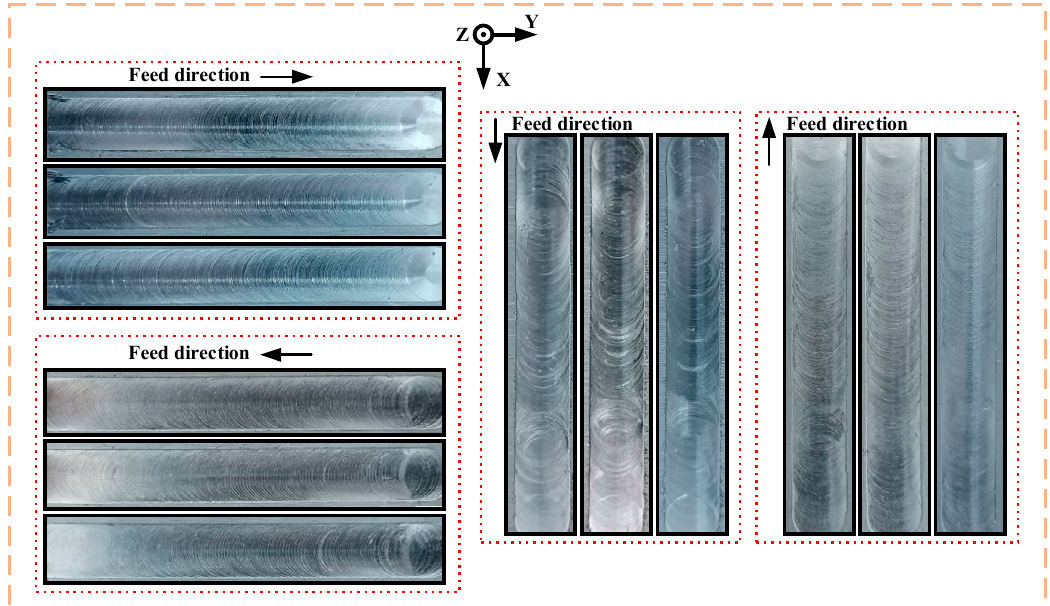
Figure 2. The machined surface results for milling by the robot in different directions.